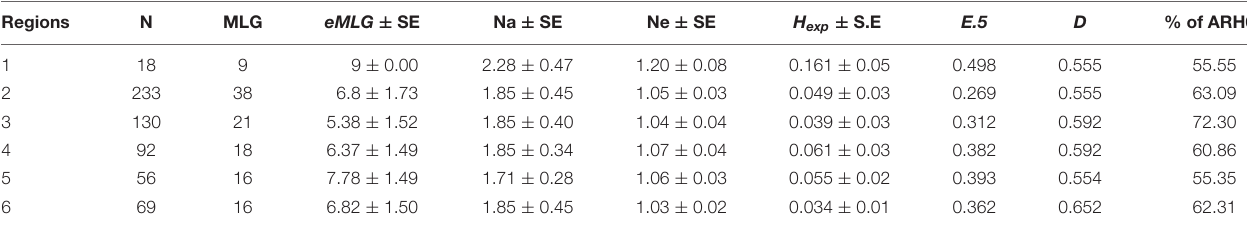
Mean D = 0.57. N = Number of individuals observed. MLG = Number of multilocus genotypes (MLG) observed. eMLG = The number of expected MLG at the smallest sample size based on rarefaction. SE = Standard error. Na = Number of different alleles (Kalinowski, 2005). Ne = Number of effective alleles (Kalinowski,